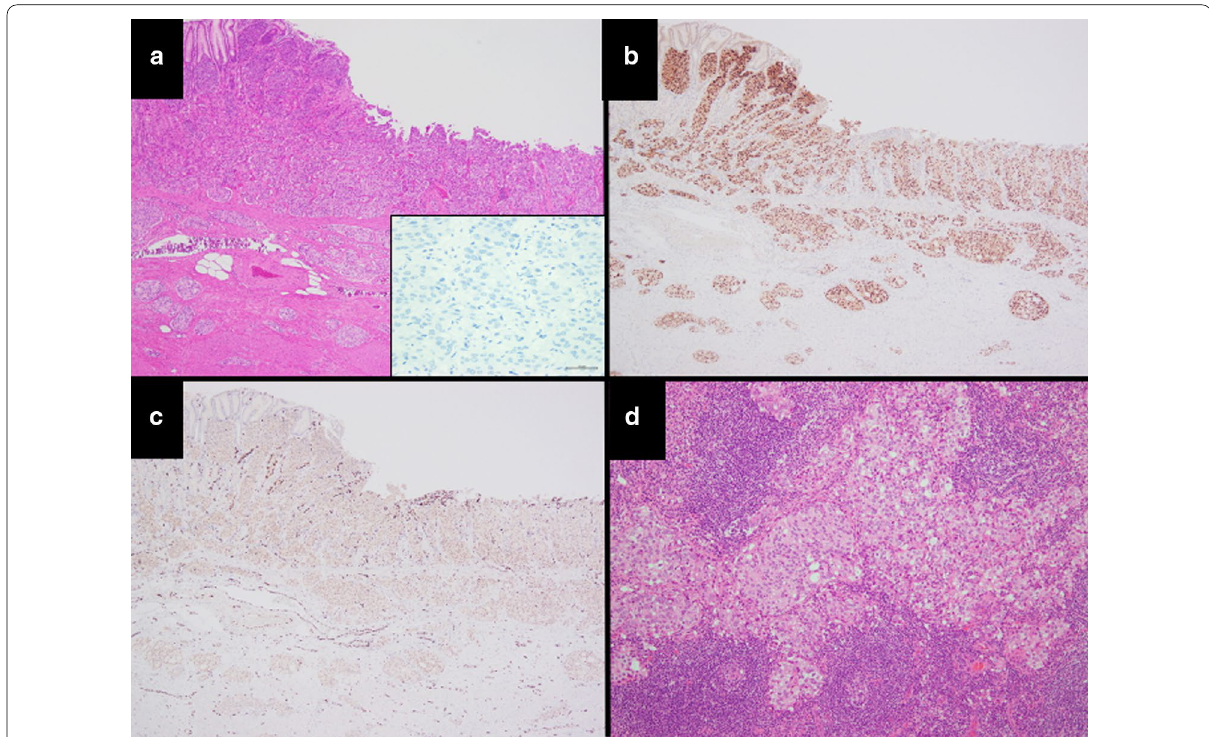
Fig. 5 Histopathological findings. a There was a proliferation of tumor cells with round-to-oval nuclei and eosinophilic to clear cytoplasm arranged in small nests or a cribriform-like pattern in the gastric wall. The tumor cells were negative for PSA ( a , inset), but positive for b androgen receptor, and c ERG in IHC. d Lymph nodes were metastasized by the cancer cells around the stomach. a , b, c